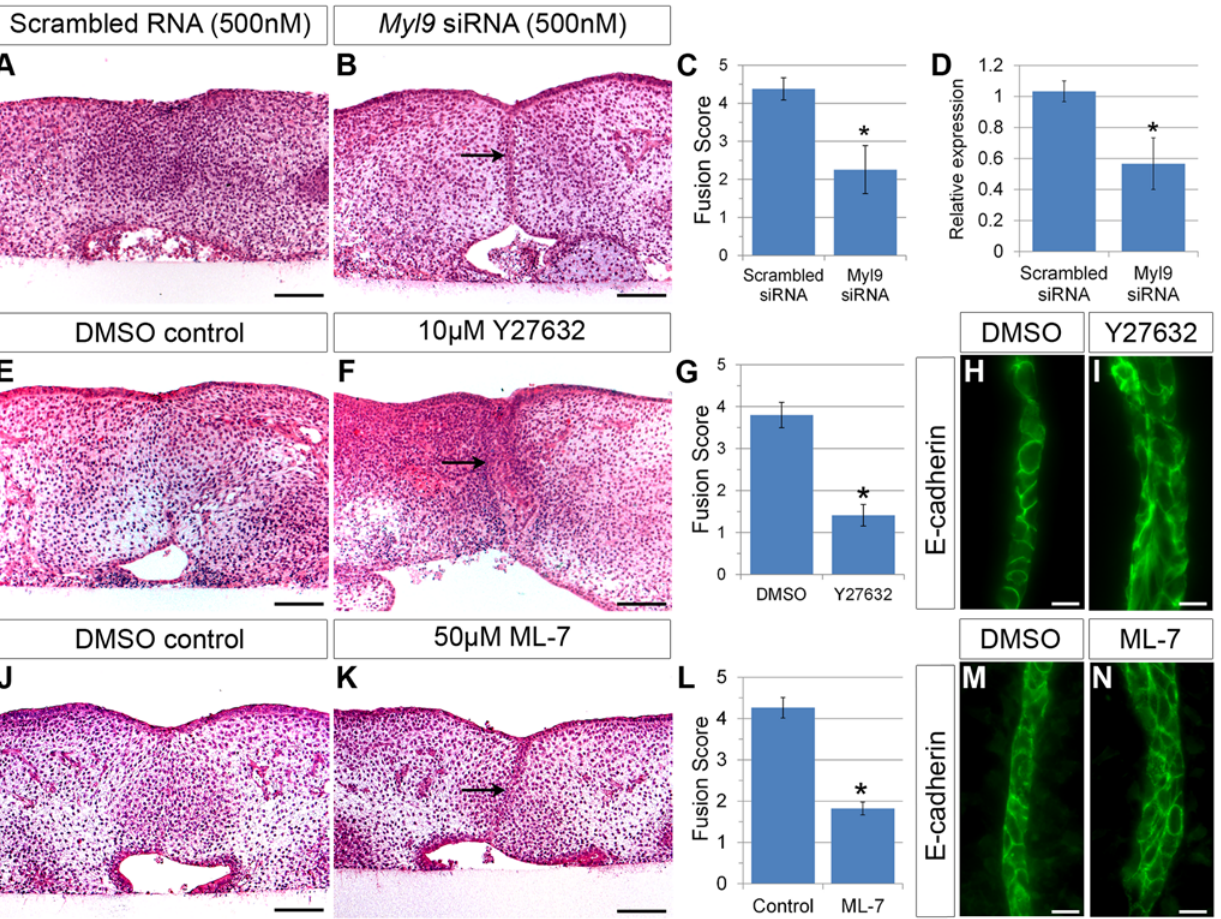
Fig 3. Inhibition of RLC Myl9 or its upstream kinases ROCK or MLCK results in defective palatal fusion. (A – D) siRNA knockdown of Myl9 resulted in significantly reduced palatal fusion (B, C) compared with control (scrambled RNA transfected) (A, C) in explants cultured for 72 h. Scale bar, 100 μ m. (D) Verification of Myl9 knockdown by siRNAs using qRT-PCR. Myl9 siRNA treatments in explant culture decreased Myl9 mRNA expression significantly. Student ’ s t test: * p < 0.05, n = 3. (E) Treatment with the ROCK inhibitor Y27632 blocked palate fusion (F, G) compared with DMSO control (E, G) in explants cultured for 72 h. Scale bar, 100 μ m. (H, I) Immunostaining of E-cadherin in Y27632-treated explants cultured for 48 h illustrates maintenance of a multi- layered MES (I), whereas the control MES (H) has thinned by this stage. Scale bar, 20 μ m. Treatment with the MLCK inhibitor ML-7 blocked palate fusion (K, L) compared with DMSO control (J,L) in explants cultured for 72 h. Scale bar, 100 μ m. Immunostaining of E-cadherin in ML-7 – treated explants cultured for 48 h showed maintenance of a multi-layered MES (N), whereas control MES had thinned by this stage (M).Scale bar, 20 μ m. In (C, G, L), data are presented